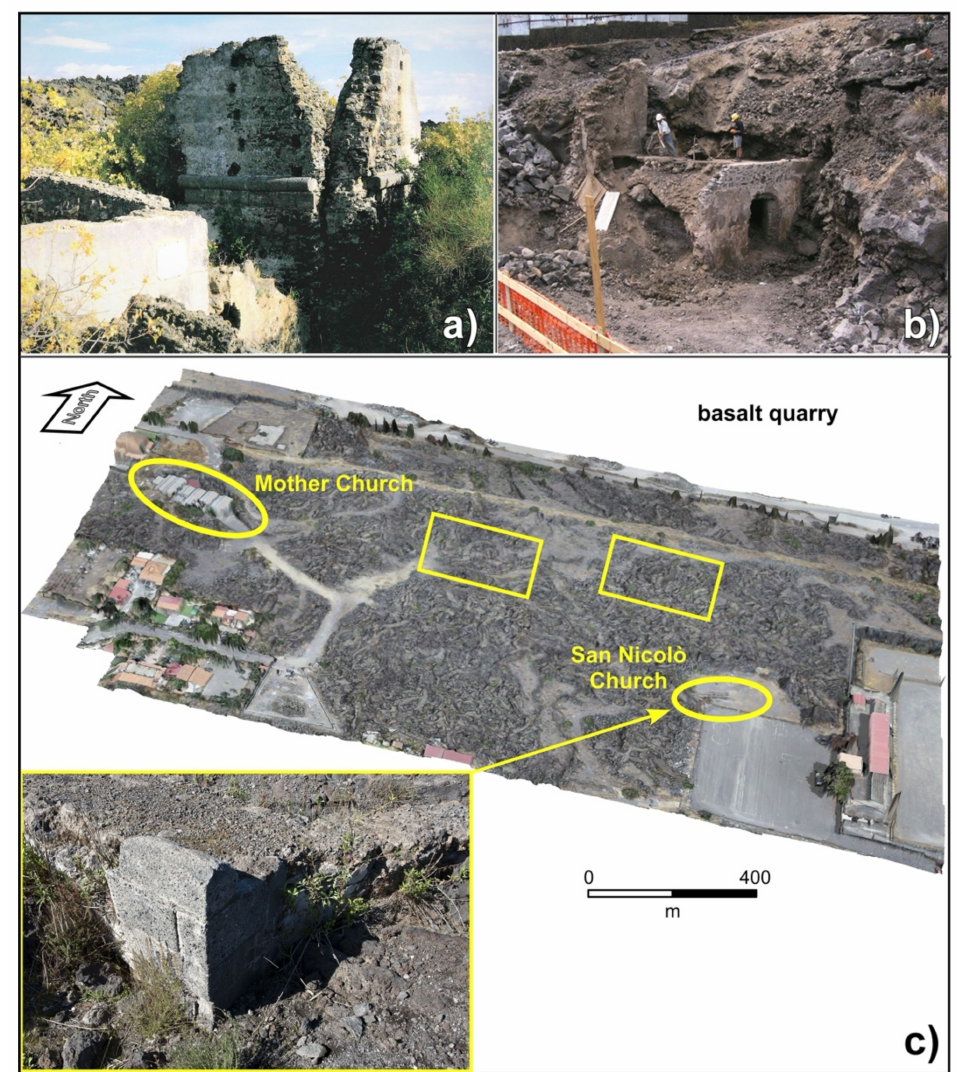
Figure 2. ( a ) The bell tower of the Mother Church, known as Campanarazzu, was the only structural element standing out from the lava field (photo from F. Privitera); ( b ) the remains of the church during the excavation works (photo from [11]); ( c ) orthophotomosaic overlapped on the digital surface model (DSM) of the investigated site, showing the position of the Mother Church and the San Nicol ò church, the remains of which are represented by the corner of a wall emerging from lava (photo taken in 2012). The two yellow boxes indicate two examples of lava morphology shown in the Figure